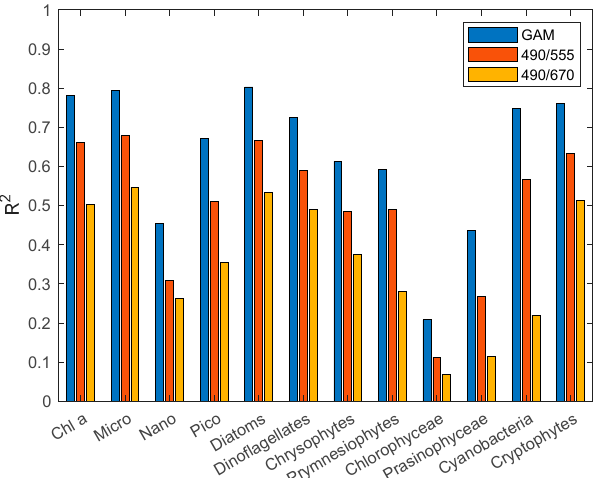
Figure 4. R 2 comparison diagram of the GAM and third-order polynomial algorithm.